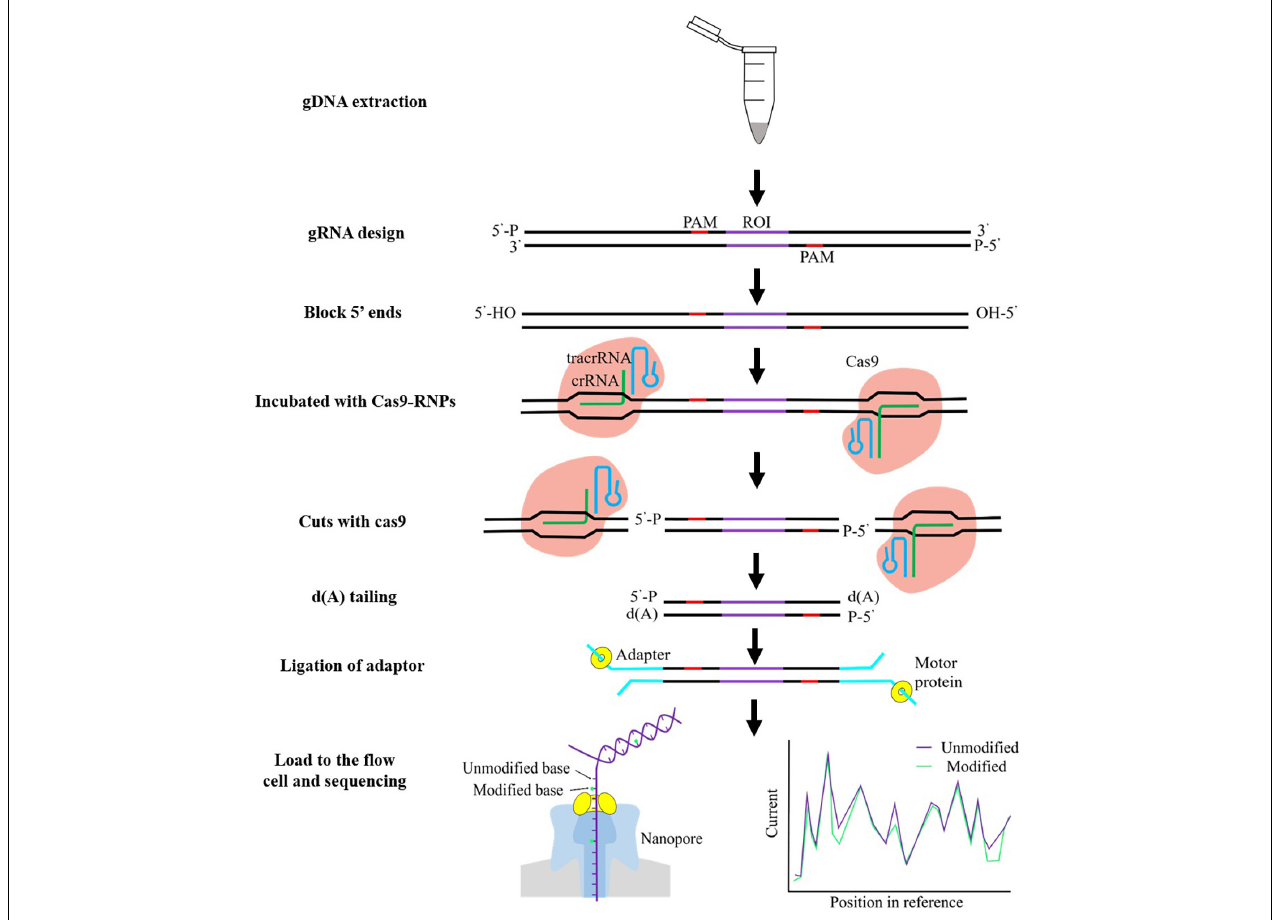
FIGURE 1 | Schematic overview of Cas9 enrichment workflow. Genomic DNA (gDNA) is first extracted from cells or tissue, guide RNA (gRNA) designed, and DNA 5 (cid:48) ends are dephosphorylated, and then Cas9 ribonucleoprotein complexes (Cas9 RNPs) were used for cleaving the region of interest (ROI). An adenine (A)-tail is rapidly added to the 3 (cid:48) ends of cut DNA fragments. ONT adapters are ligated to cut end around the ROI. The sequencing library is carefully cleaned to remove excess adapters using AMPure XP beads. The prepared library is loading onto the flow cell for sequencing. DNA modifications can be detected by nanopore sequencing. As the single-stranded DNA moves through the pore, it causes disruptions to the ionic current in a sequence-dependent manner, generating a readout known as a “squiggle.” The current signal highlighted with green lines indicates small changes due to the methylated